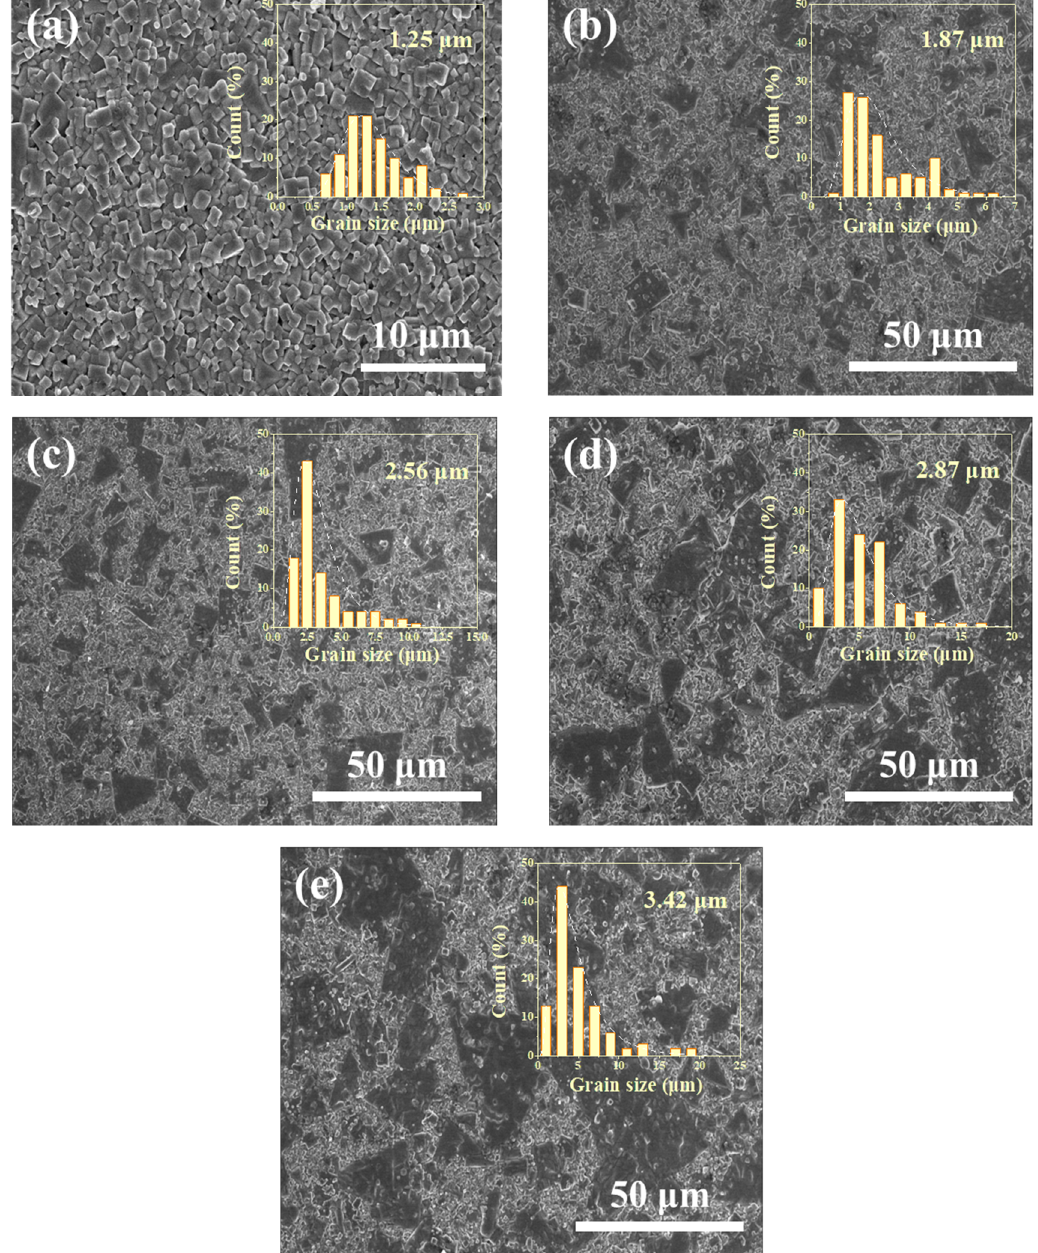
Figure 2. SEM images of the NKLNTS-ST- x CuO ceramics doped with ( a ) x = 0 mol%, ( b ) x = 0.5 mol%, ( c ) x = 1.0 mol%, ( d ) x = 1.5 mol% and ( e ) x = 2.0 mol%.